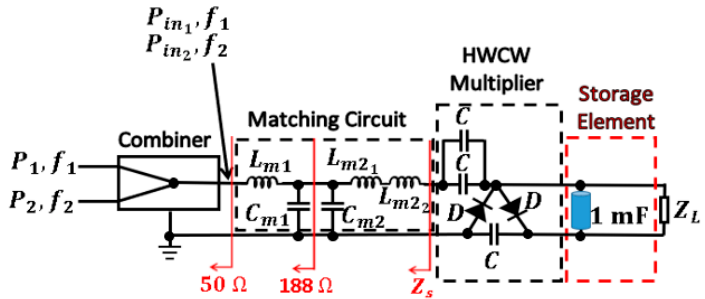
Figure 16. Setup used to obtain the charge and discharge curves of the 1 mF storage capacitor.